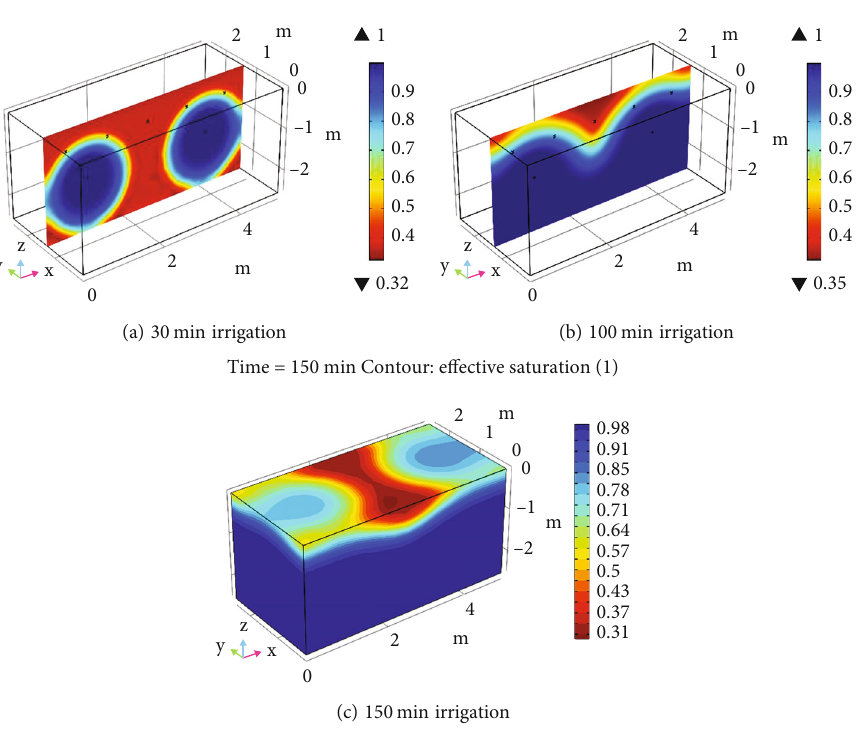
Figure 4: E ff ective saturation in the system for case I-A at di ff erent periods.